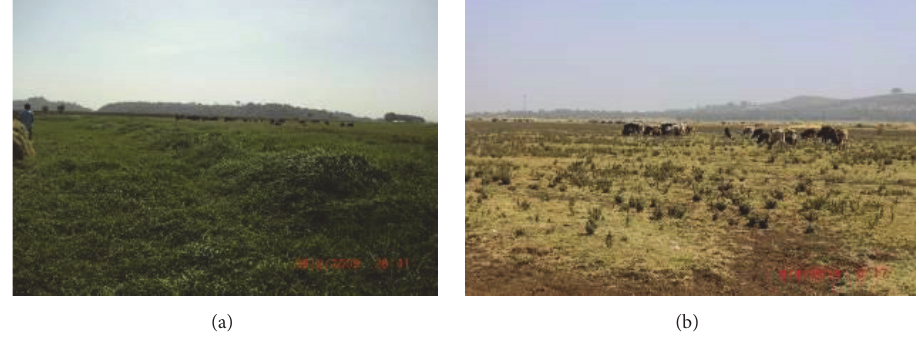
Figure 6: Assendabo ( Phalaris paradoxa ) (a) and Amekela ( Asteracantha longifolia ) invaded grazing land